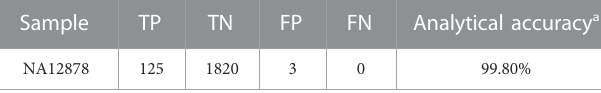
TABLE 5 Accuracy. Analytical Accuracy.